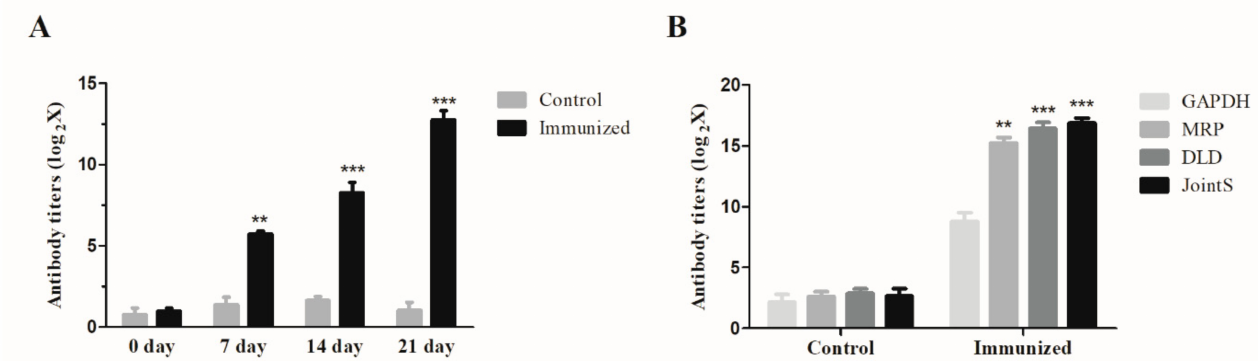
Figure 4. Antibody titers in the vaccinated piglets. Antibody titers were tested by ELISA using inactivated SS2 ( A ) or purified GAPDH, MRP, and DLD proteins ( B ) with immunized sera. Samples collected from each piglet were tested in triplicate. In ( A ), an unpaired Student’s t -test showed the antibody titers in the JointS immunized mice were significantly higher than PBS-immunized mice in different time points. In ( B ), Kruskal Wallis test followed by Dunn’s post-hoc test showed the specific antibody titers against GAPDH were significantly lower than MRP, DLD, or JointS. *** p < 0.001 and ** p < 0.01. The error bars represent